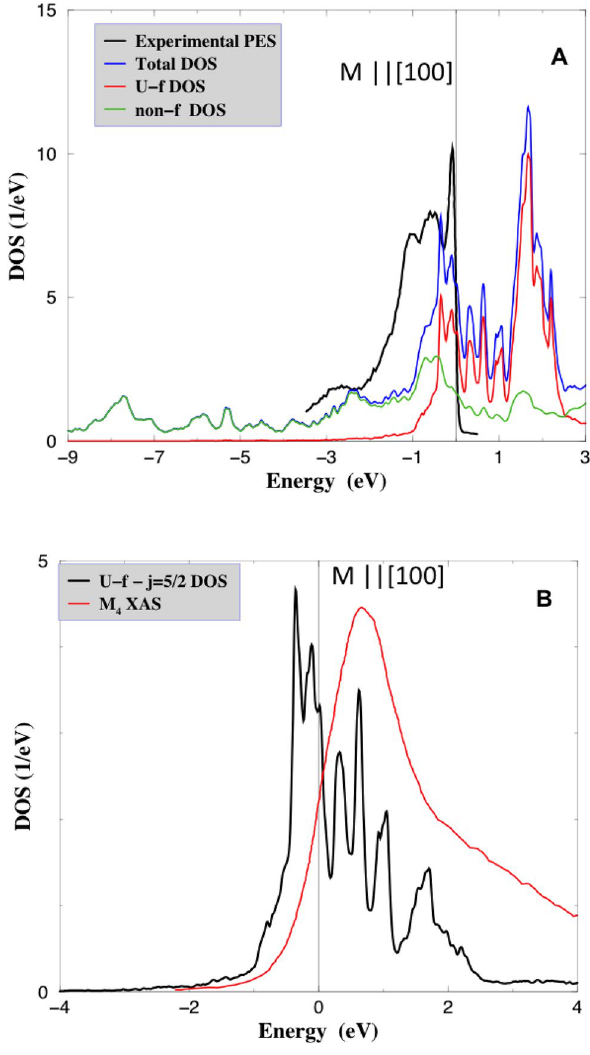
Figure 1. UGa 2 —( A ) Experimental photoelectron spectra (black line) from 20 are compared to the total DOS, orbital-resolved U-5f and a sum of all non-f DOS. ( B ) Experimental HERFD XAS spectra for U-5f (black line) from 9 are compared to the calculated j = 5 / 2 -projected U-f DOS. All theoretical DOS correspond to the ferromagnetic solution with [100] magnetic moment